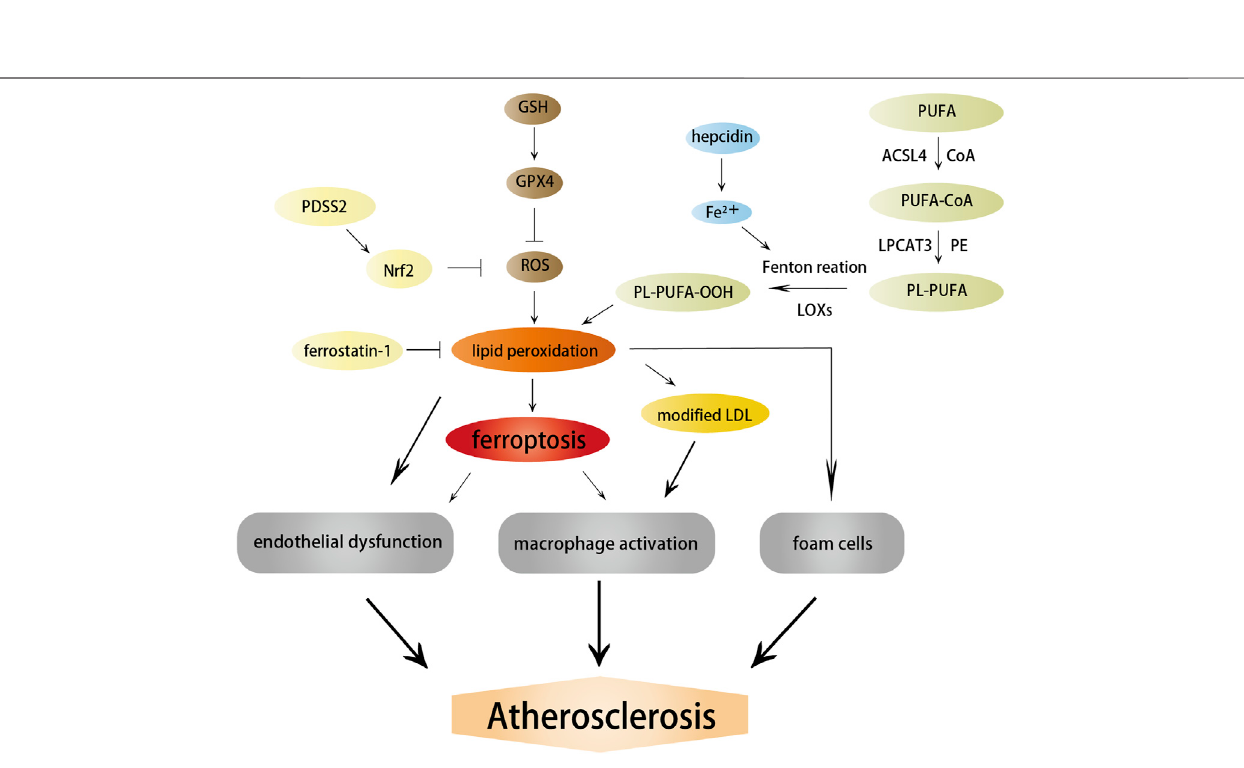
Frontiers in Cell and Developmental Biology |